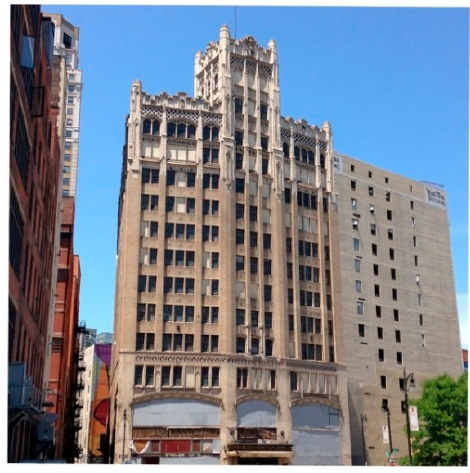
Figure 4. Metropolitan and Wurlitzer Buildings, vacant before renovation.